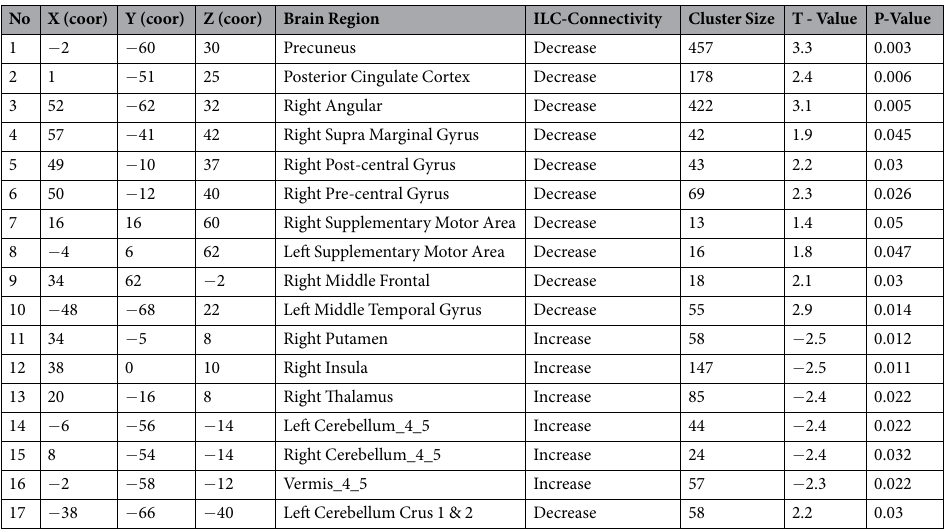
Table 1. Regions revealing significant DLC differences between awake and sedation state. The t-values represent the strength of ILC connectivity between the voxel and its neighboring correlated voxels. Cluster size represents the number of voxels correlated in the brain region. The p-value represents the corrected significance level of the ILC